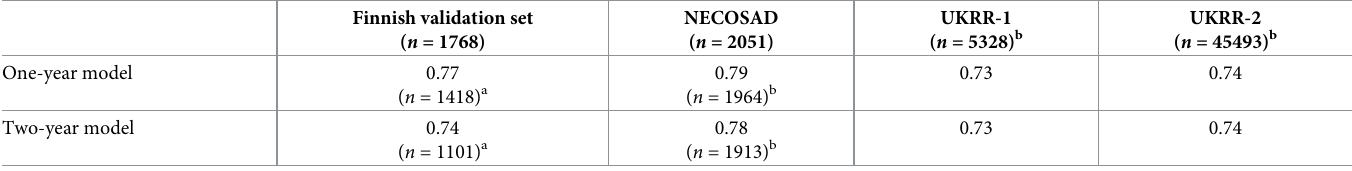
Table 4. Predictive ability of the study models using c-statistic (area under the curve, AUC). Results of external validation according to data